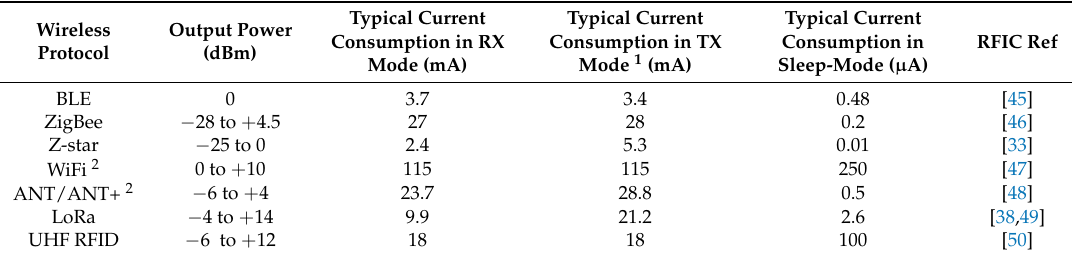
Table 3. Survey of low-power RF Integrated Circuits transceivers available commercially. Wireless